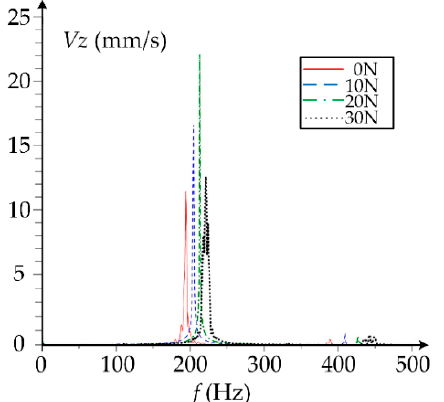
Figure 6. The bearing vibration under different radial loads when L = 1.1.